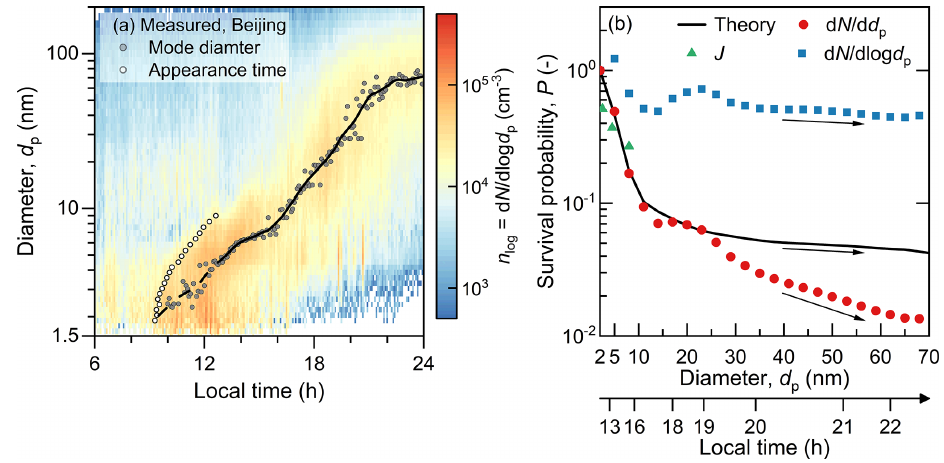
Figure 5. Survival probabilities of new particles in a measured new-particle-formation event in urban Beijing. (a) Measured size distribution of new particles. The growth rate is determined using the mode-fitting method (Kulmala et al., 2012). For sub-5nm particles, the mode-fitting method is likely to underestimate the growth rate (see “Methods” section), as indicated by its different slope from the trajectory retrieved using the appearance time method (Lehtipalo et al., 2014). (b) The measured and theoretical survival probabilities of new particles along the trajectory. The theoretical survival probability of sub-5nm particles has been corrected using the growth rate reported by the appearance time method. The arrows indicate the trend of the survival probability of 25–70nm particles. A non-linear axis shows the local time corresponding to the growing particle size, indicating potential atmospheric variations during the growth of new